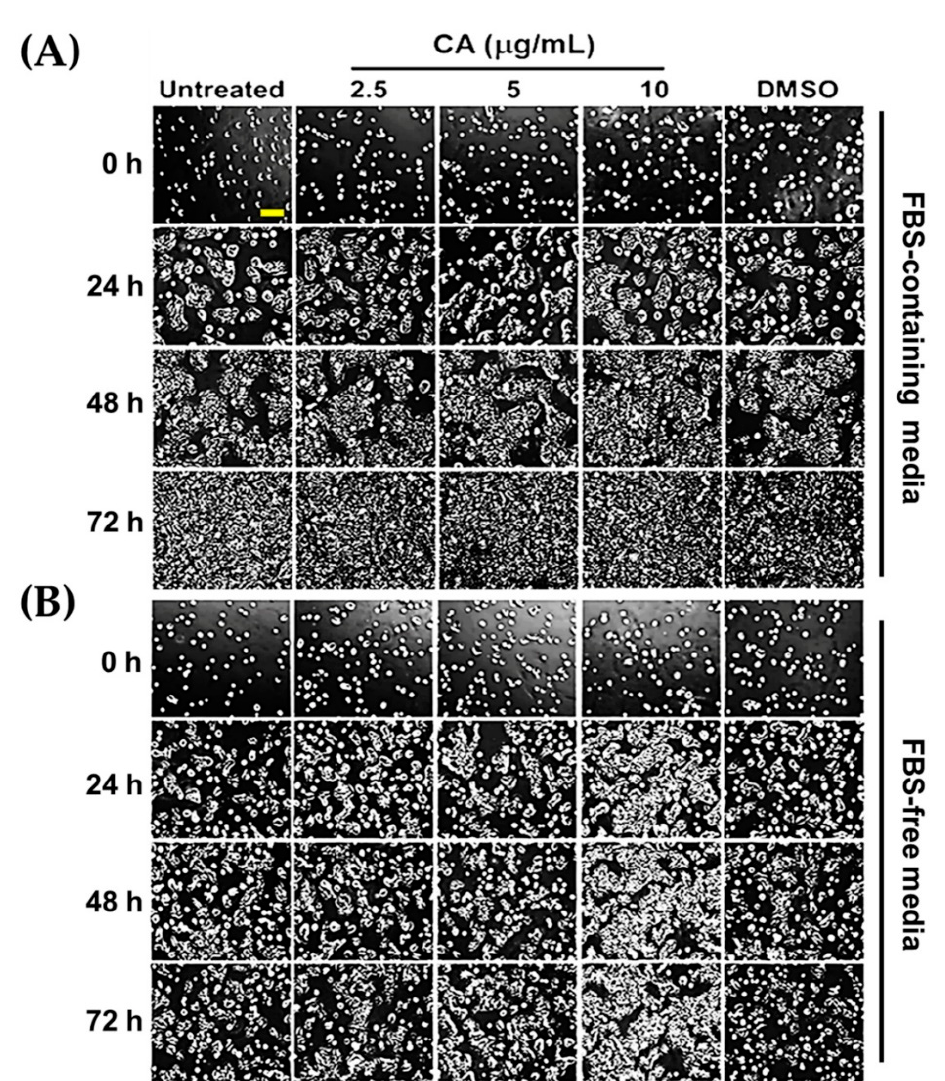
Figure 3. CA extract induced the growth of HaCaT colonies. HaCaT cells were left untreated or treated with CA extract at 2.5, 5, and 10 g/mL in media containing 10% FBS ( A ) or in media without the presence of FBS ( B ). The sizes of HaCaT colonies were monitored, and the pictures were captured at 0, 24, 48, and 72 h by a phase-contrast microscope (10 × magnification, scale bar = 200 µm). Cells were also treated with DMSO which served as a vehicle control. The pictures were representative of three individual experiments.